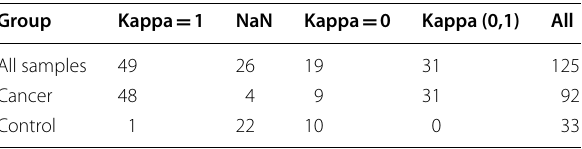
Table 2 The kappa values of supernatant and sediment